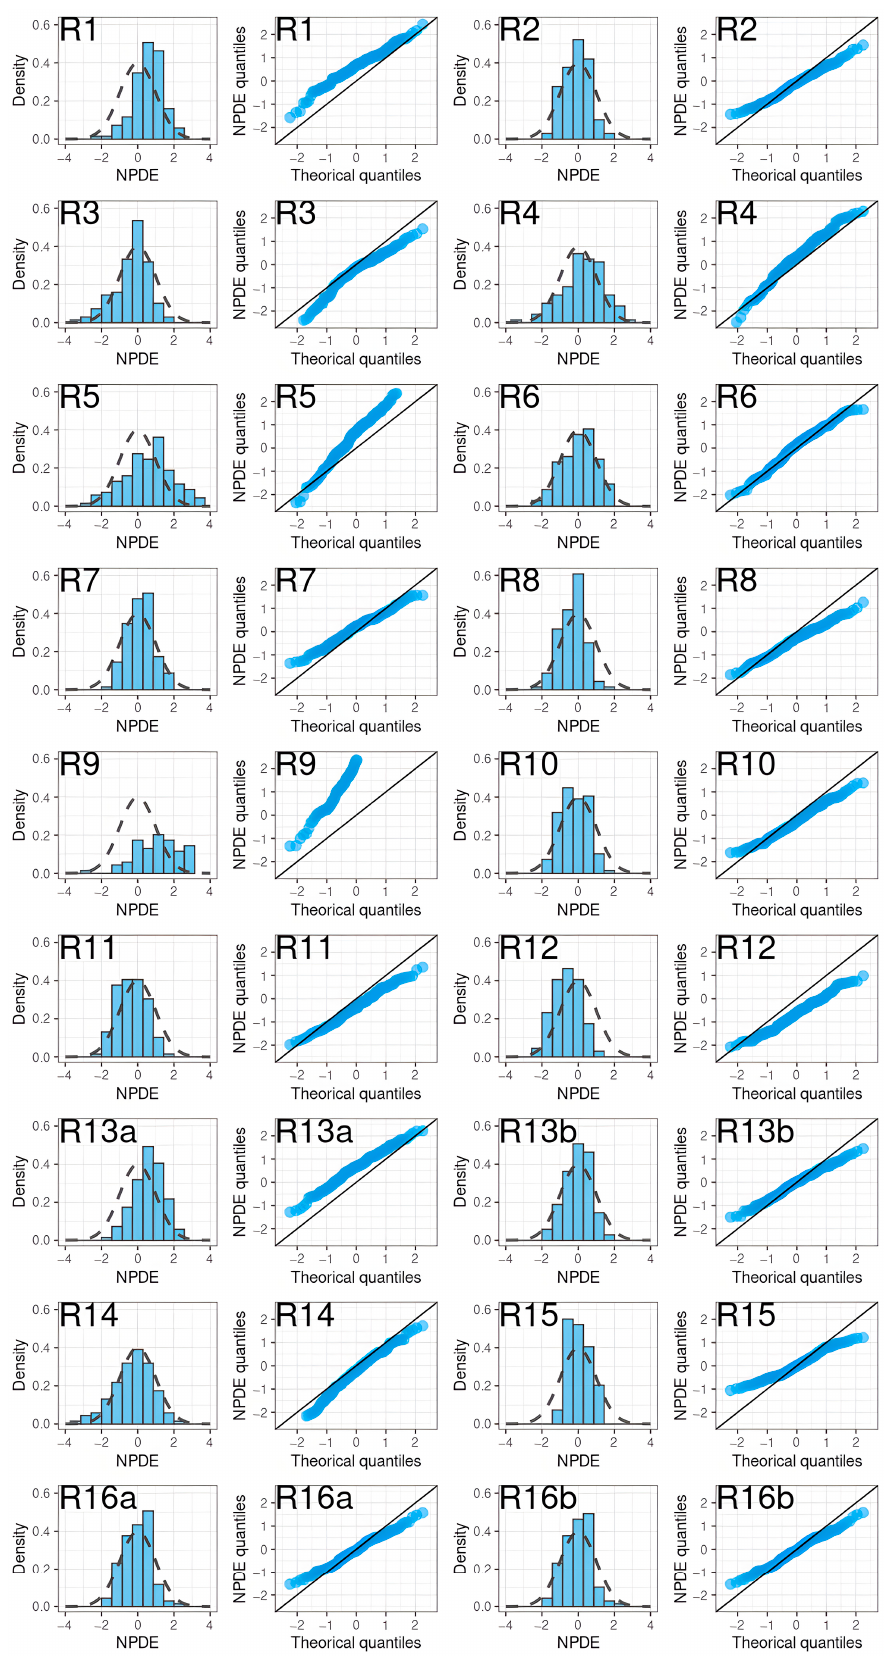
Figure 7. NPDE histograms and QQ plots of rivaroxaban population pharmacokinetic studies applied to the external validation